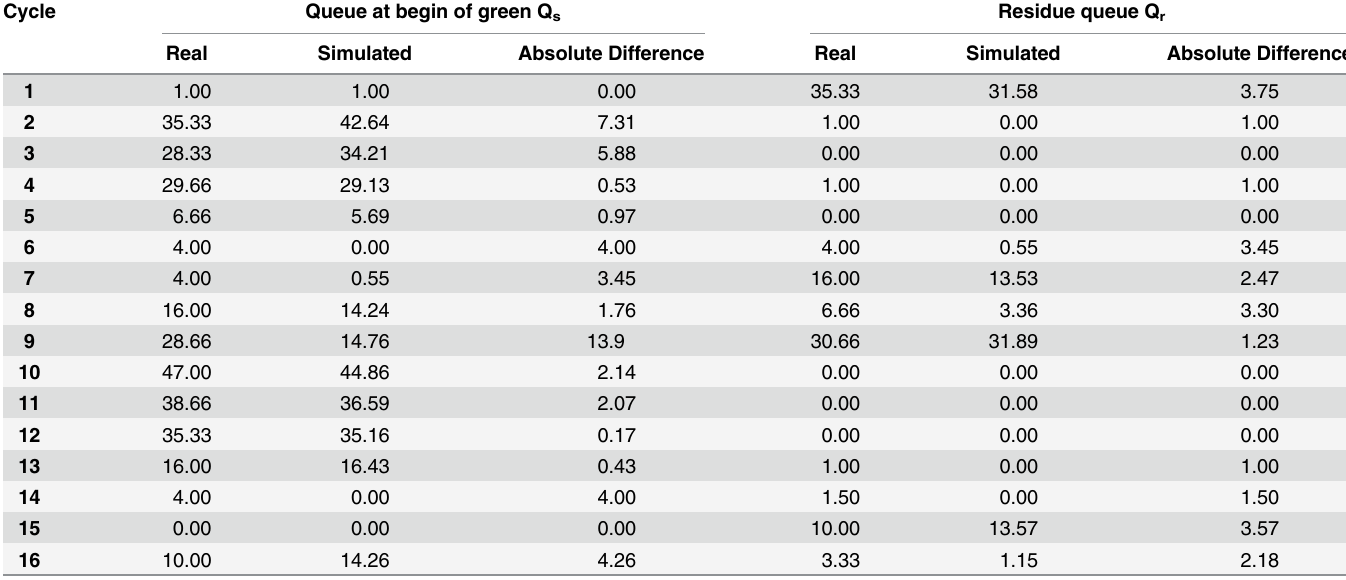
Table 7. Simulated and real queues of Persiaran Kuala